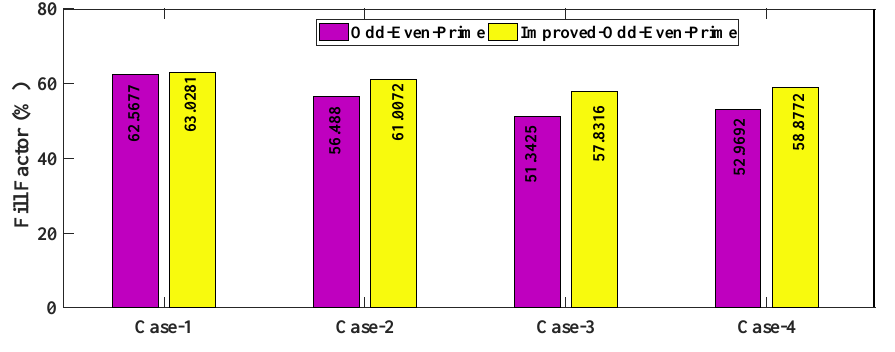
Figure 27. Fill-factor for 8 × 9 PV array.